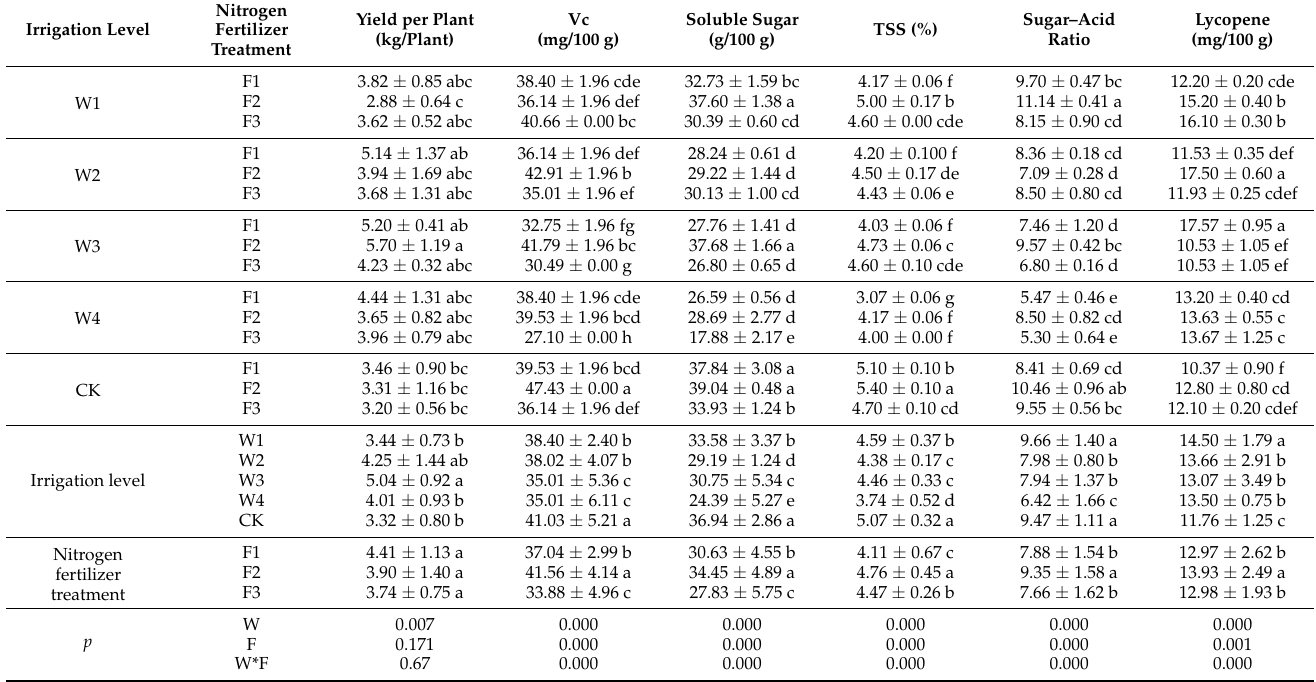
Table 4. Effects of different treatments on tomato yield and